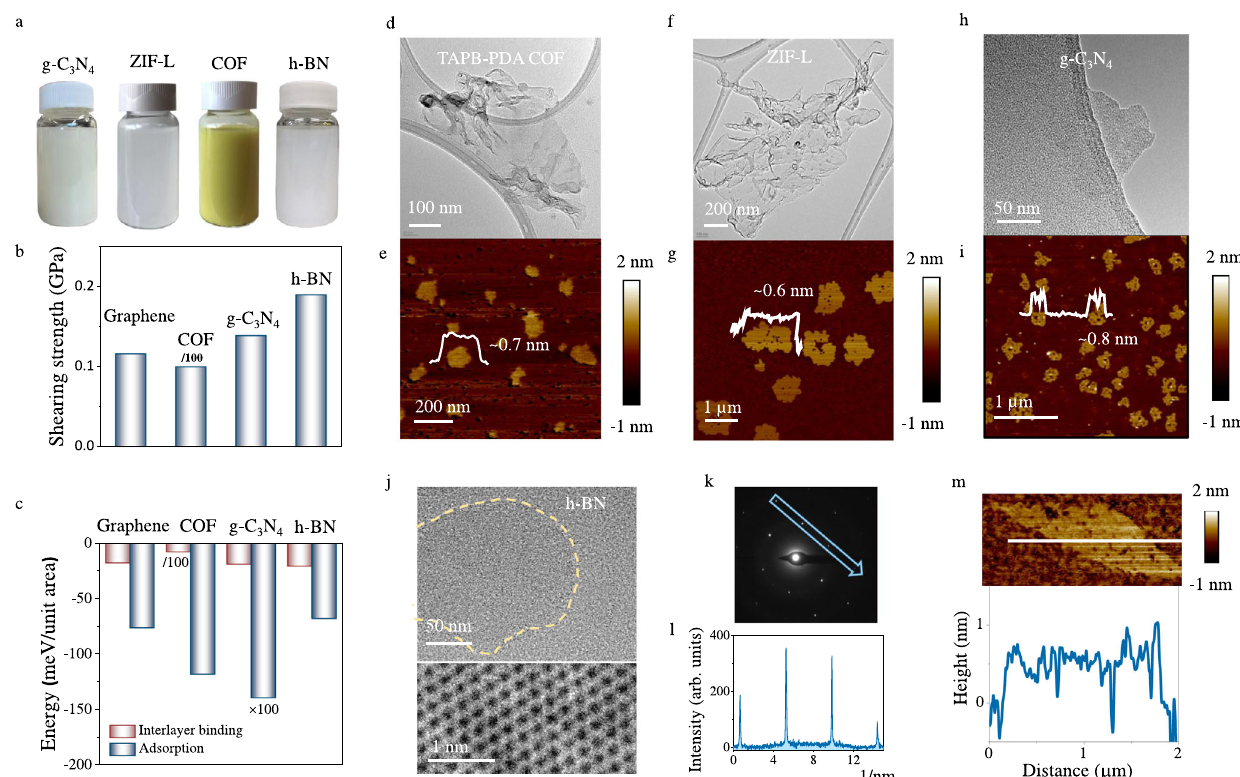
Fig.4|Exfoliationofotherlayeredmaterialsbystickymilling.a Photographsof exfoliated graphitic carbon nitride (g-C 3 N 4 ), TAPB-PDA covalent organic